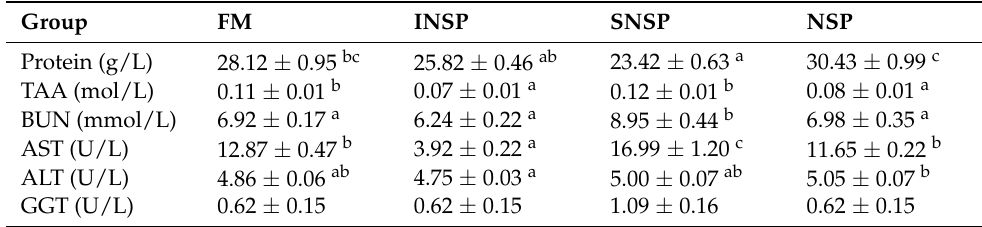
Table 4. Plasma protein metabolism indicators of grass carp fed by test feeds.